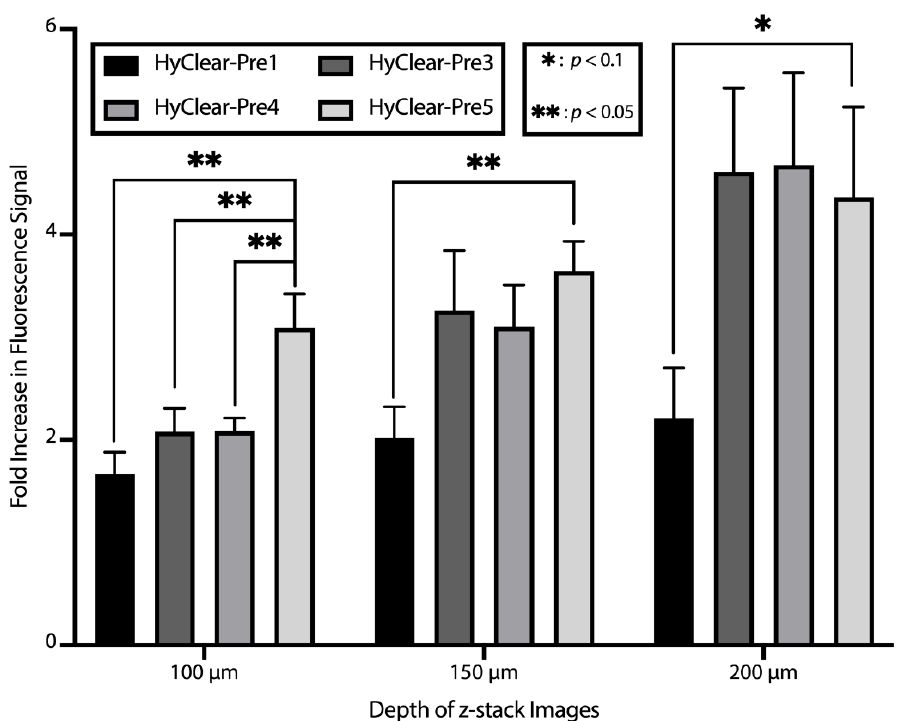
Figure 6. The average fold increase in the fluorescence signal after clearing in different imaging depths using different clearing methods versus HyClear. The p -values are calculated using a heteroscedastic two-tailed t -test. The error bars represent the standard error of the mean of five–six replicates.